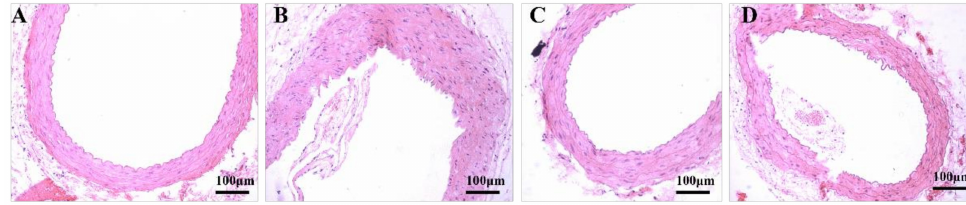
Figure 5. The iliac artery. NC group ( A ), SC group ( B ), ST group ( C ), and LT group ( D